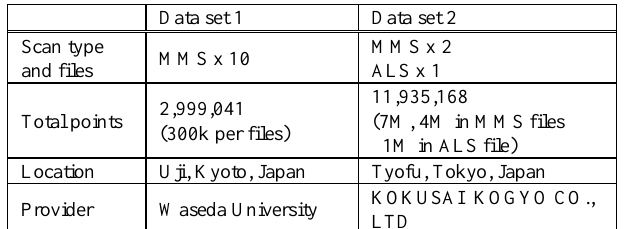
Figure 7. A result of searching by measurement time